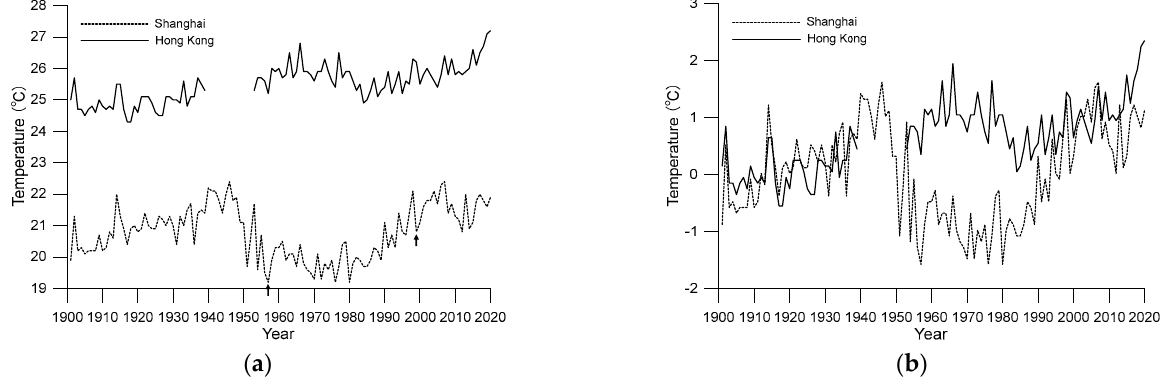
Figure 5. Annual average maximum temperature from 1901 to 2020 for the Shanghai and Hong Kong observatories (( a ) original observations; ( b ) anomalies to the average values during 1901– 1930).